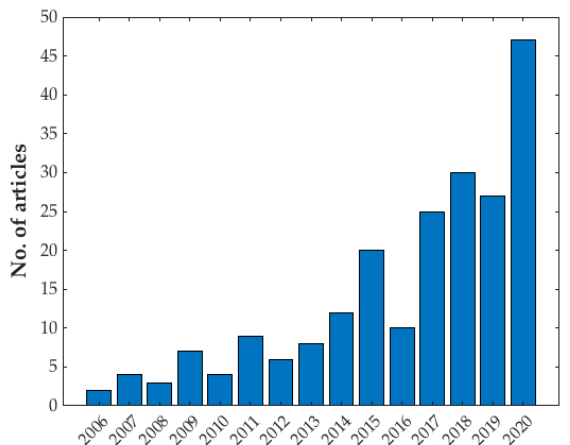
Figure 1. Number of indexed articles appeared in the last 15 years related to coarse-graining and DEM. Source: data extracted by the database Scopus ® with the following research key: TITLE-ABS-KEY ((“coarse-grain*”) and (“DEM” or “Discrete Element M*”)).